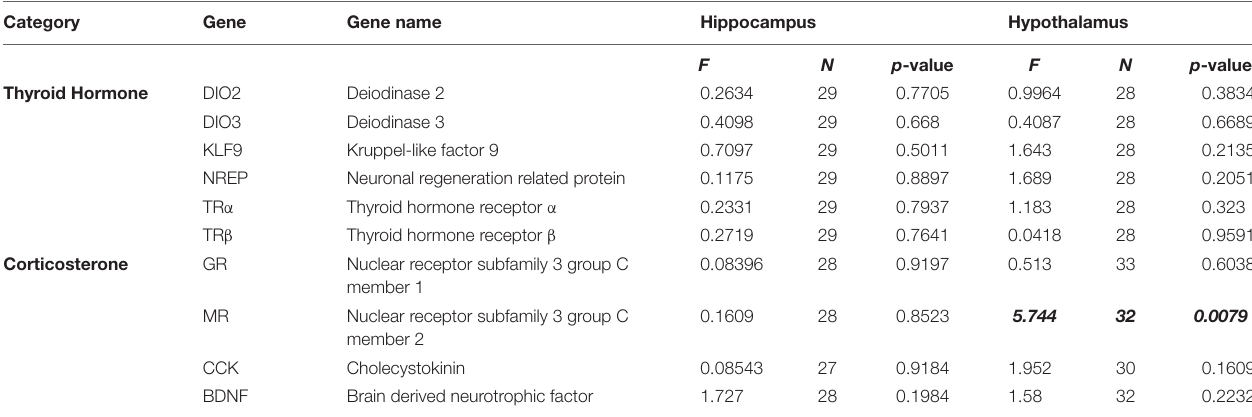
TABLE 2 | Summary of statistics.